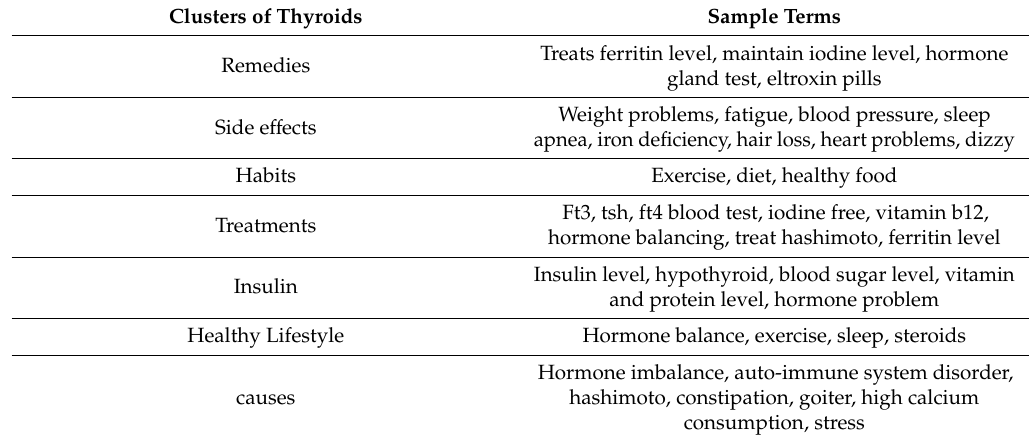
Table 1. Sample keywords extracted from each cluster of thyroid.